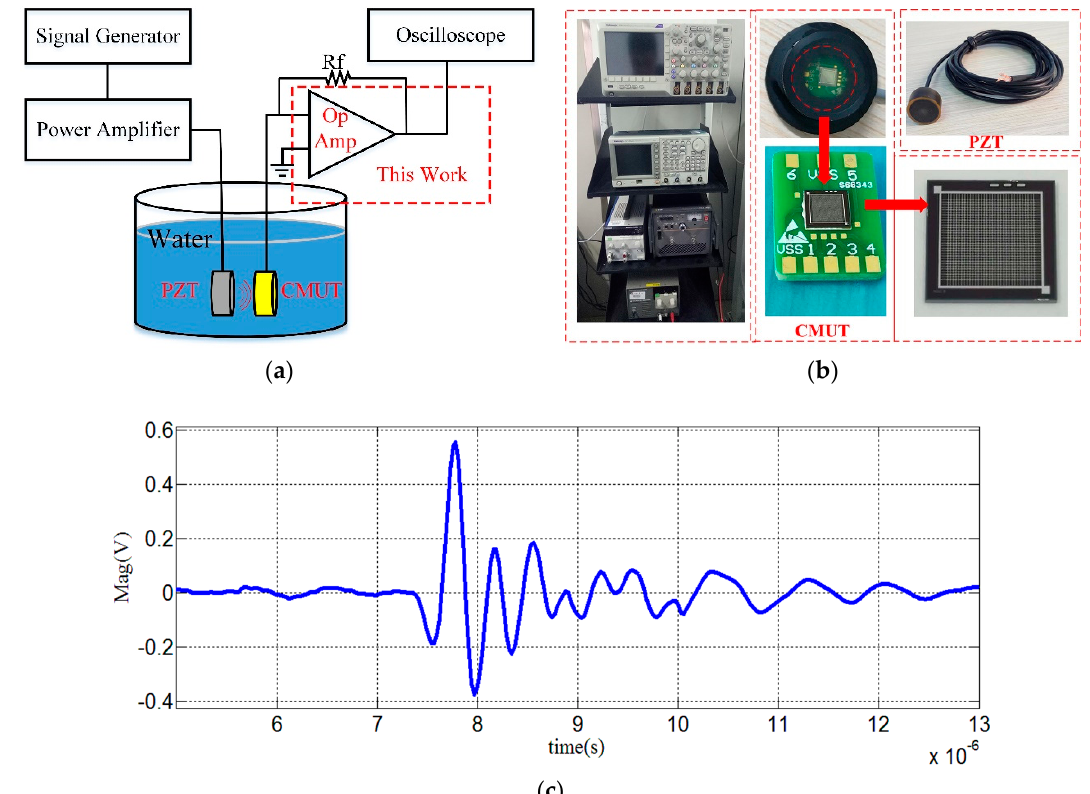
Figure 6. Functional test of the amplifier with the encapsulated CMUT. ( a ) Schematic diagram of the CMUT receiver circuit for the functional test; ( b ) measurement setup for the amplifier with an encapsulated CMUT and a PZT; and ( c ) the received signal of the CMUT.